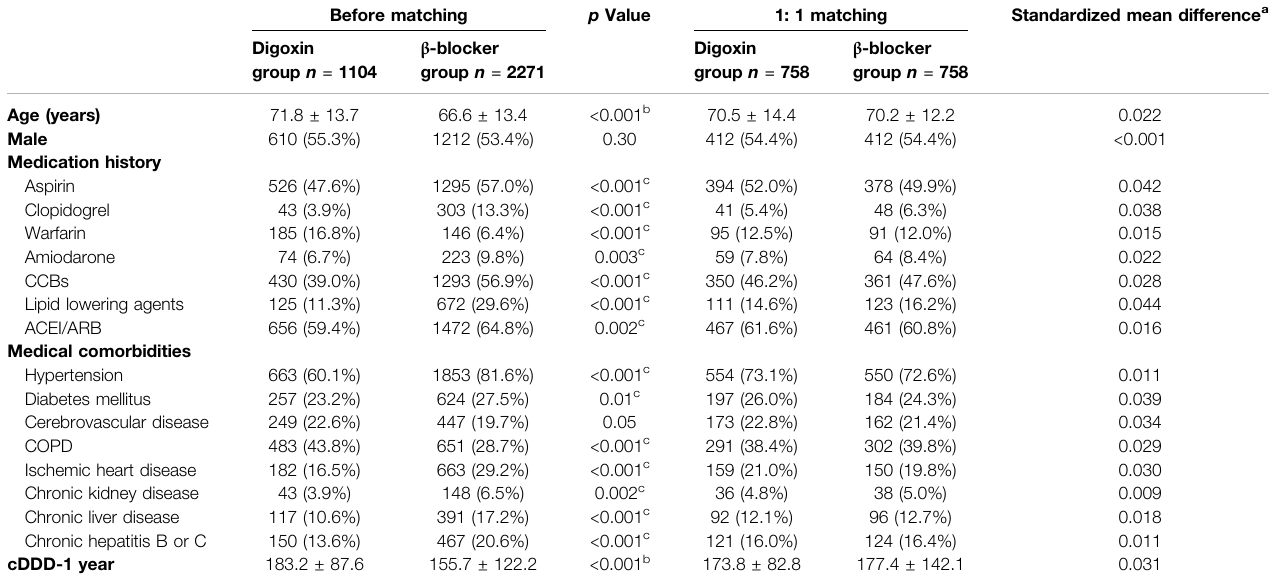
TABLE 1 | Clinical demographics of patients before and after 1:1 propensity score-matching. Before matching p Value 1: 1 matching Standardized mean difference